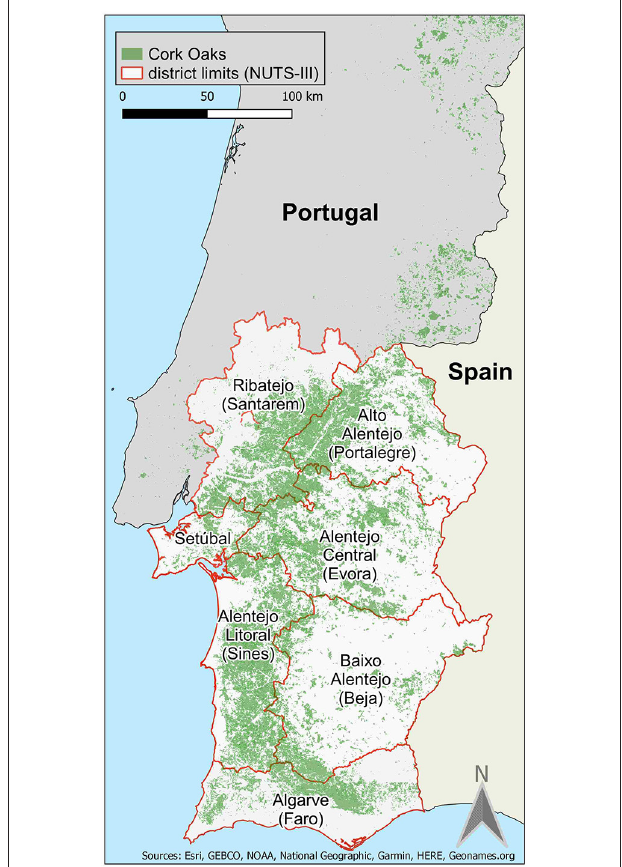
FIGURE 1 | Map displaying the current distribution of Quercus suber L. in Portugal, and the administrative borders of the associated districts (NUTS-III).